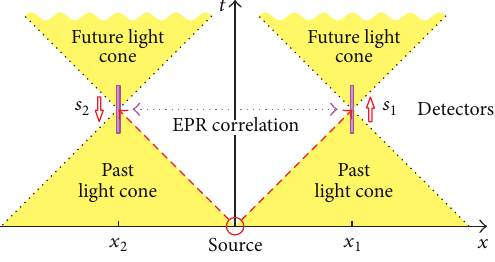
Figure 1: Sketch of the typical laboratory ERP experiment.